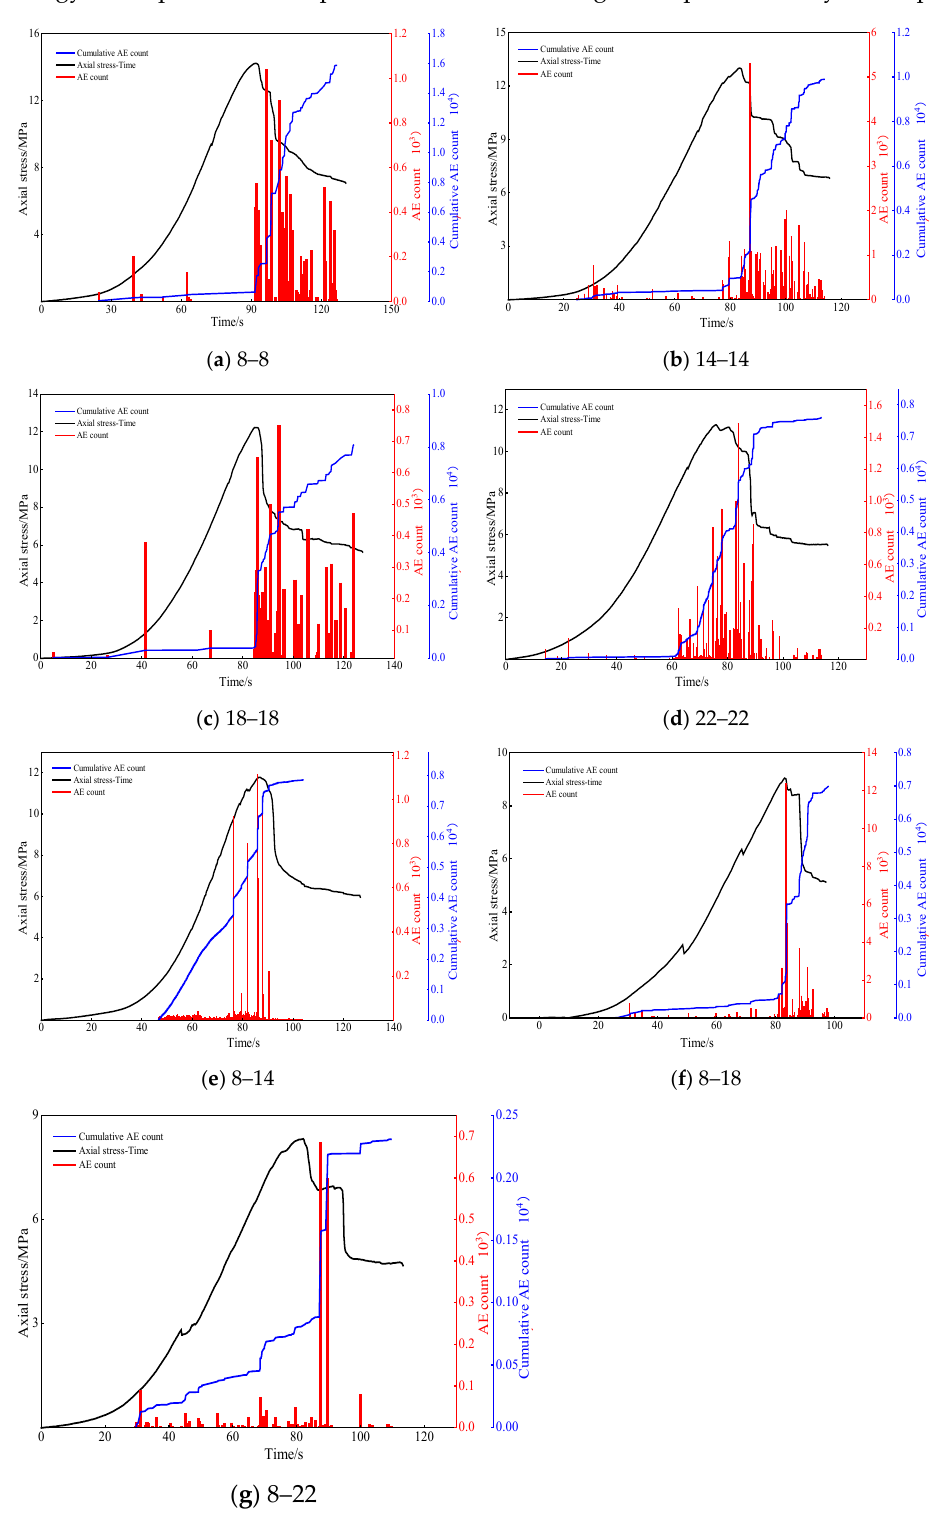
Figure 11. Curve of stress–strain and AE counting characteristics of each borehole sample. It can be seen from Figure 12 that the cumulative AE counts of samples with different sizes and borehole shapes behave pretty differently. The cumulative AE counts of samples with the same − diameter and variable − diameter decrease gradually with the increase of borehole size. There is a negative correlation between borehole size and cumulative AE counts. The cumulative AE count of the sample numbered 8–8 is 15,880 and of the sample numbered 22–22 is 7595, a decrease of 52.17%, while the AE count of the sample numbered 8–22 is 2309, a decrease of 70.63% compared with the sample numbered 8–14. The signif- icant reduction of the AE count indicates the weakening of the sample internal activity intensity. It can be seen from the figure that the AE activity frequency of sample with a variable − diameter borehole is greater than that of the same − diameter borehole, showing the phenomenon of low frequency and high amplitude. It can be seen that variable − diam- eter drilling can weaken the strength of the sample, which is helpful for the graded release of energy in the process of sample failure and weakening the impact tendency of sample. ( a ) ( b ) Figure 12. Cumulative AE count of each borehole sample: ( a ) is Cumulative AE count of same − di- ameter drilling samples; ( b ) is Cumulative AE count of variable − diameter drilling samples. 5. Failure Mode and Fracture Evolution Characteristics In Figure 13, 8–22 (8) represents the sample numbered 8–22 and contained an 8 mm drilled part, 8–22 (22) represents the sample numbered 8–22 and contained a 22 mm drilled part. It can be seen from Figure 13a that there are three tensile cracks in the sample, but these do not penetrate to form an effective pressure relief zone, as the failure form is mainly tensile splitting.